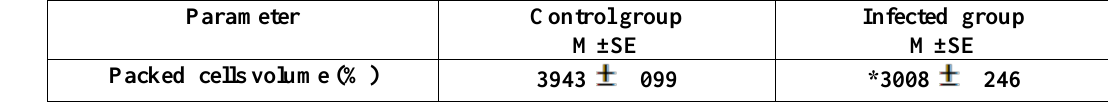
Table (5) Effect of E coli infection on mean of Packed cell volume (PCV).